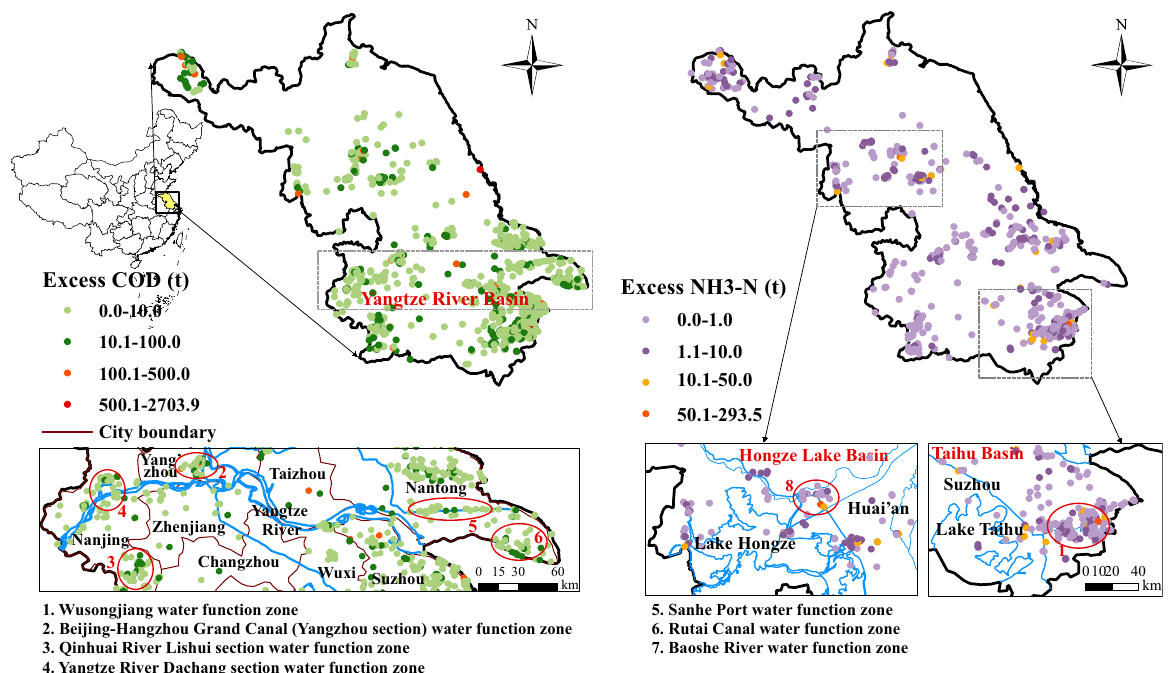
Fig. 1 Distribution of the industrial enterprises in Jiangsu Province with excess pollution discharge (tons/yr). a Excess COD and b excess NH 3 -N. The dots in the fi gure show the locations of the enterprises with excess pollution discharge while the colours represent the amount of territorial-based excess industrial pollution. Three basins, where enterprises with excess pollution discharge are densely distributed, are partially enlarged, including the Yangtze River Basin, Hongze Lake Basin, and Taihu Basin. Ten hotspot water function zones, which cover most enterprises with excess pollution, are marked. The blue lines represent the main